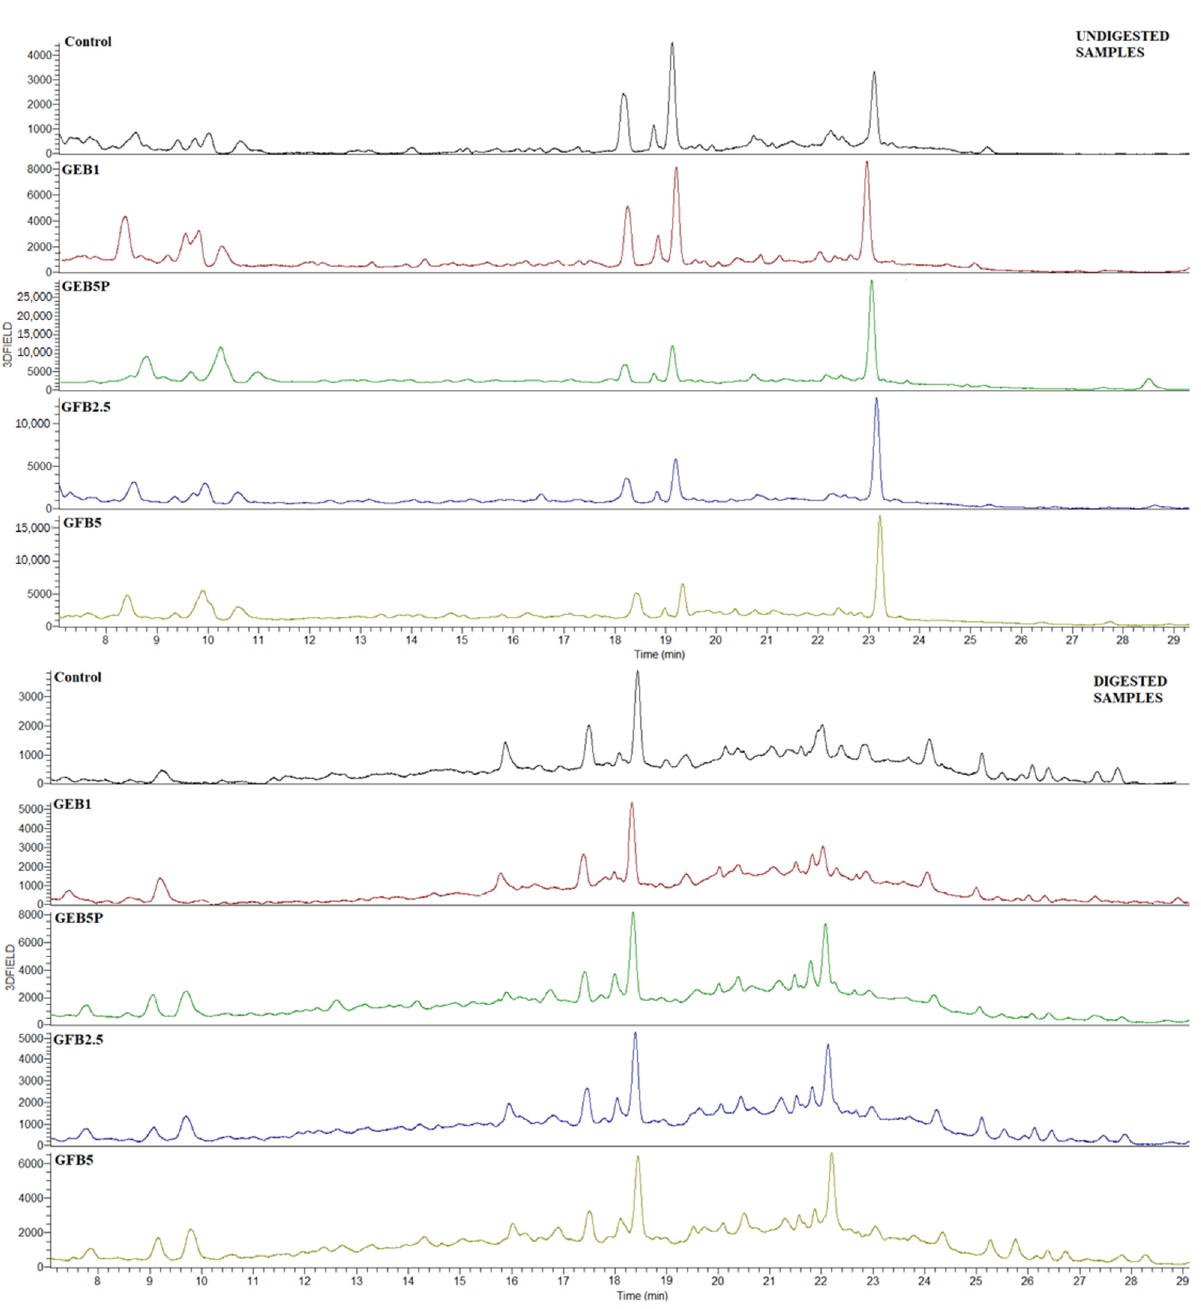
Figure 1. HPLC chromatograms of extractable phenolics before and after in vitro digestion of control and bioprocessed breads. Detection was achieved at 310 nm. Control: wheat bread with no added bioprocessed flour; GEB1: wheat bread enriched with 1% “germinated + enzymatic treated” spelt flour; GEB5P: wheat bread enriched with 5% pasteurized “germinated + enzymatic treated” spelt flour; GFB2.5: wheat bread enriched with 2.5% “germinated + fermented” spelt flour; GFB5: wheat bread enriched with 5% “germinated + fermented” spelt flour.